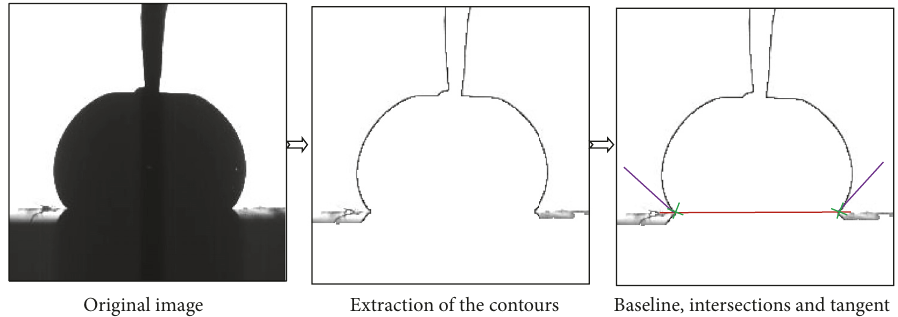
Figure 2: Measurement of contact angle using image-processing